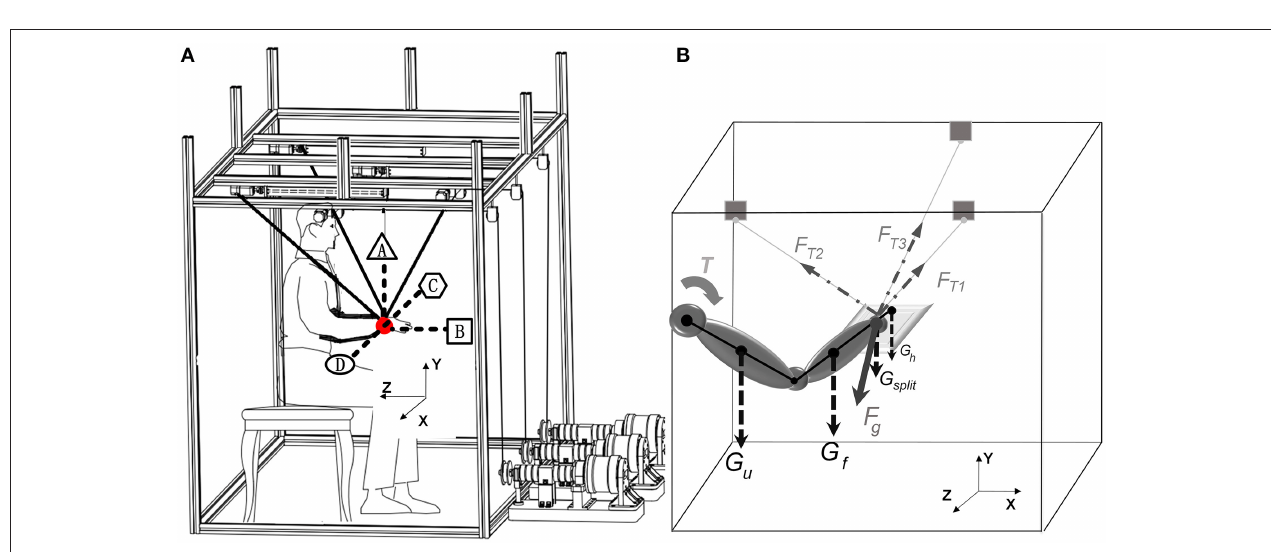
FIGURE 2 | (A) The tasks directions and (B) static force